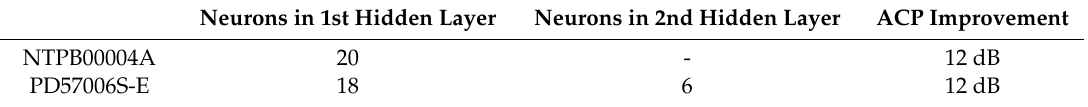
Table 5. Neural network structures required to obtain the same ACP improvement for the selected LDMOS and GaN amplifiers.